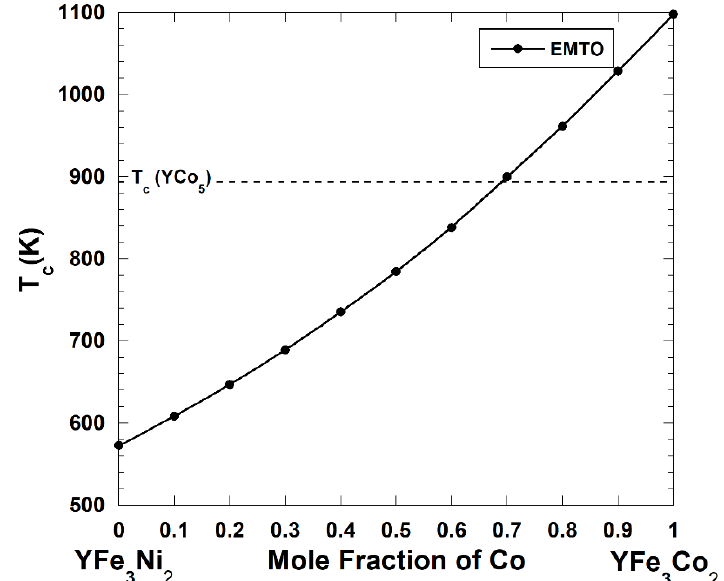
Figure 4. The Curie temperature of the pseudo-binary YFe 3 (Ni 1-x Co x ) 2 alloys. The dotted line corresponds to the calculated Curie temperature of the YCo 5 magnet.